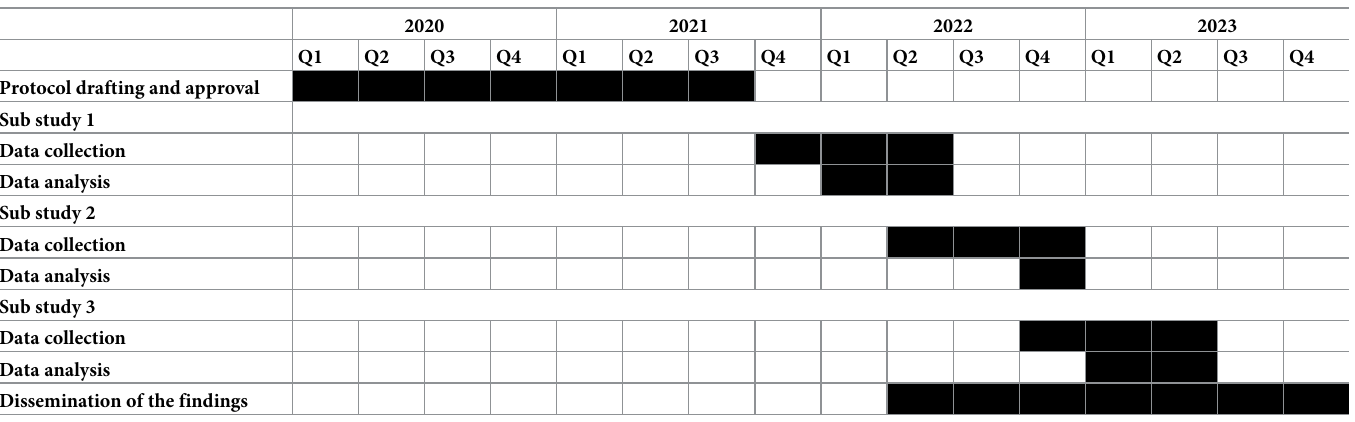
Table 1. Timing of the activities of the